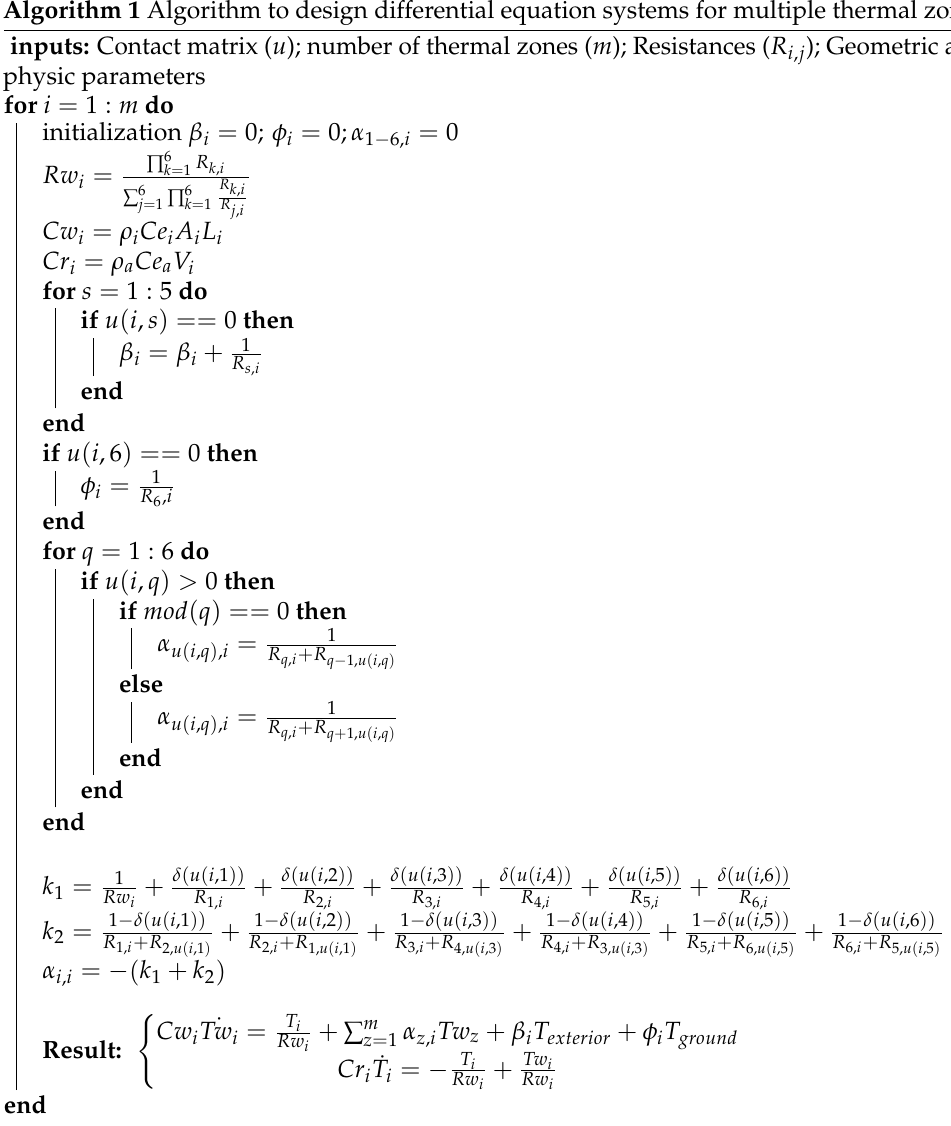
Algorithm 1 Algorithm to design differential equation systems for multiple thermal